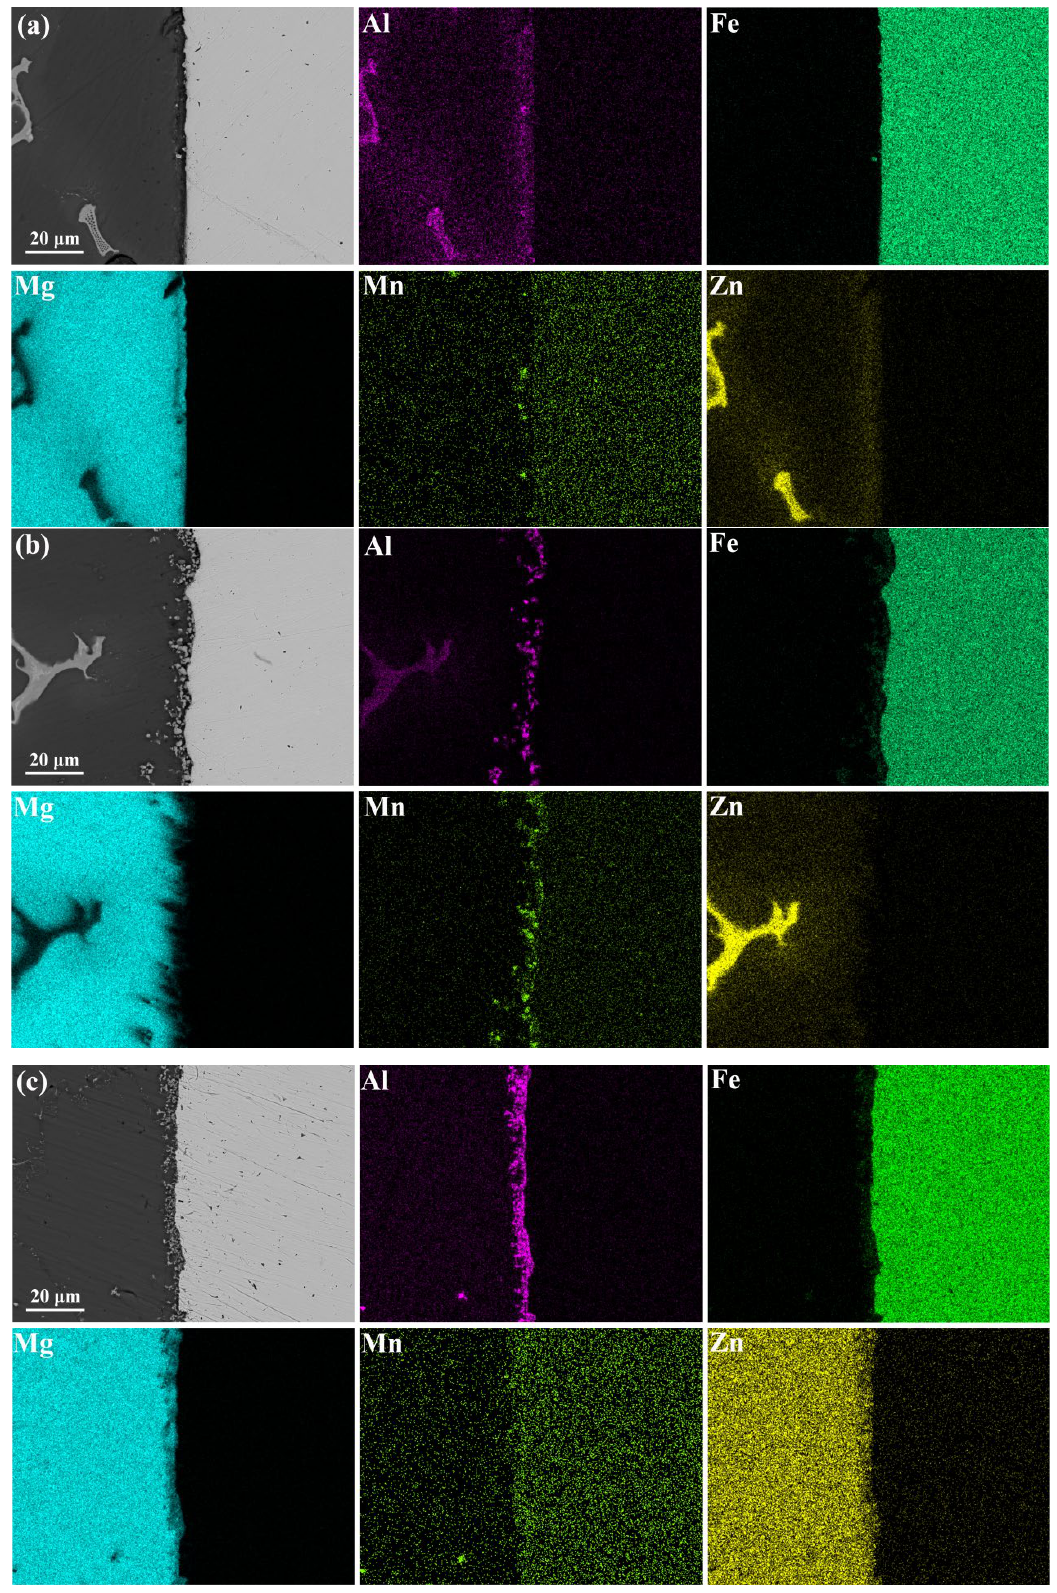
Figure 7. EDS mapping of the interfacial of ( a ) AZ63/Q235, ( b ) AZ63/galvanized Q235, and ( c ) AZ63/galvanized Q235 + T6.